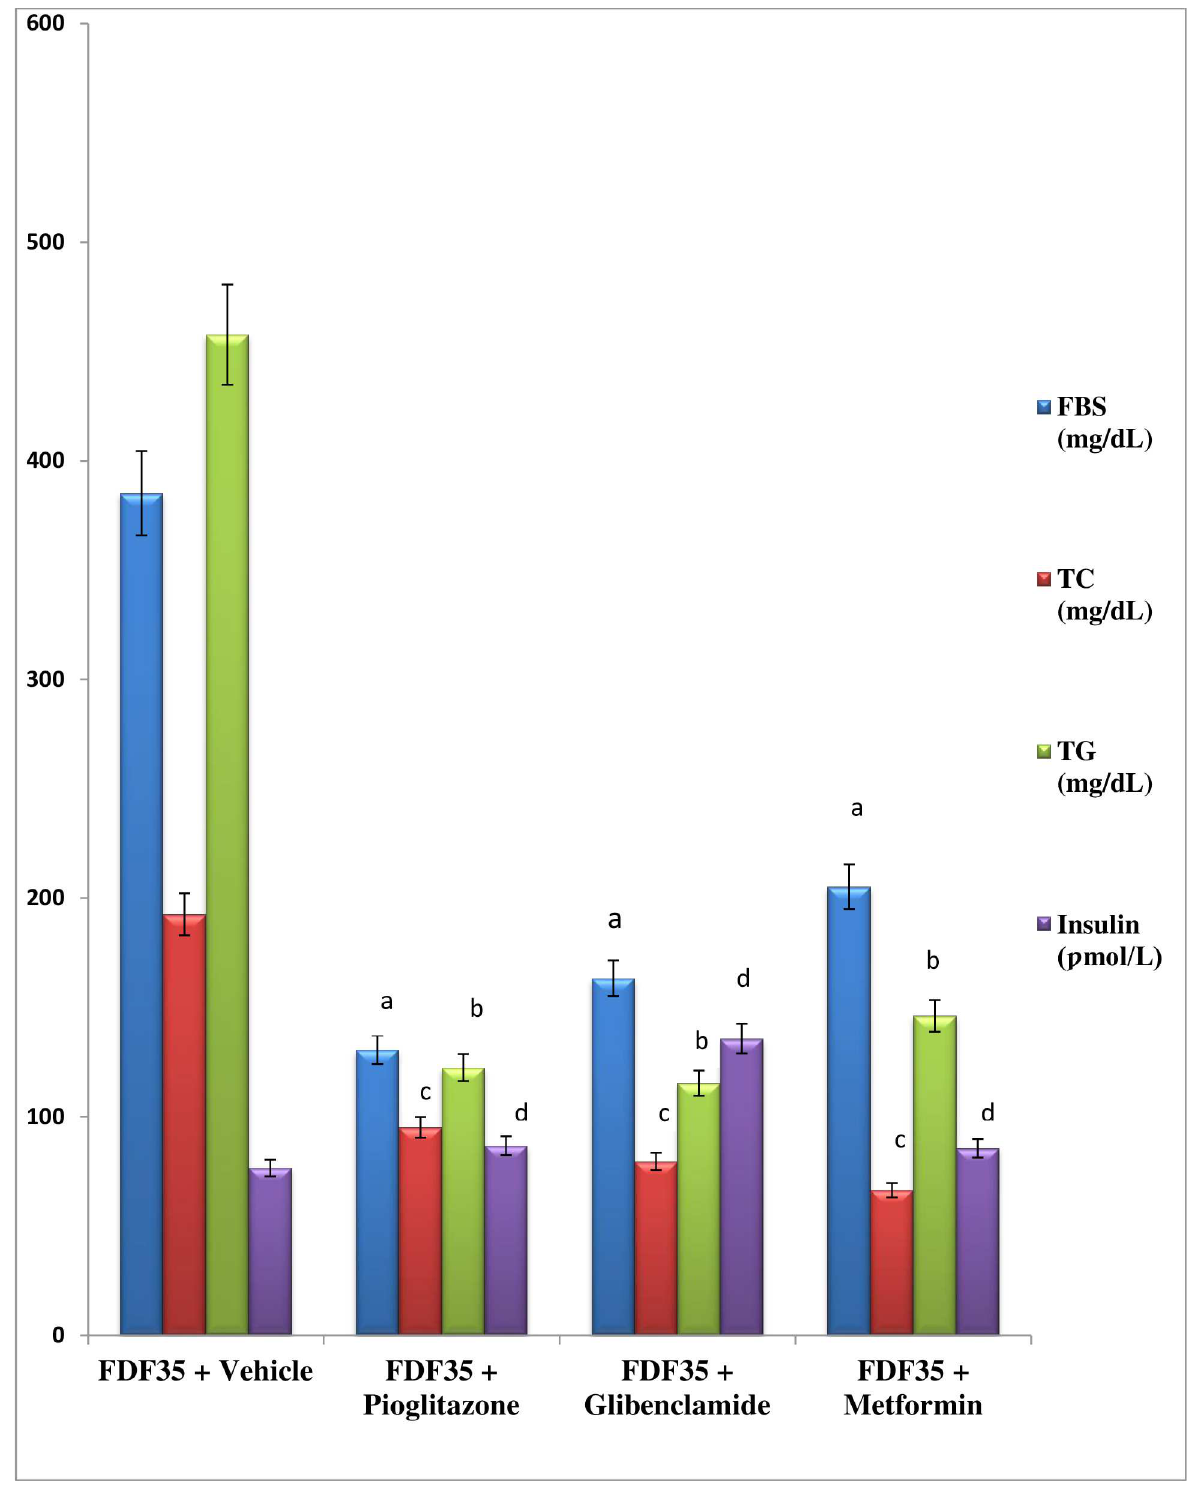
Fig 5. Effect of Pioglitazone, Glibenclamide and Metformin on Blood Glucose, Total Cholesterol and Triglyceride in FDF-Fed, STZ Treated Rat Model of Type 2 Diabetes. Data are presented as mean ± SD of 6 animalsper group. TC: total cholesterol, TG: triglyceride, FBS: fasting blood sugar. FDF 35 : Group fed with Normal Diet Feed + Water and treated with 35mg/kg bw, STZ.“a, b, c, d” P (cid:20) 0.05versus“FDF 35 + Vehicle”. Conversionfactor: Insulin (1U/l = 7.174